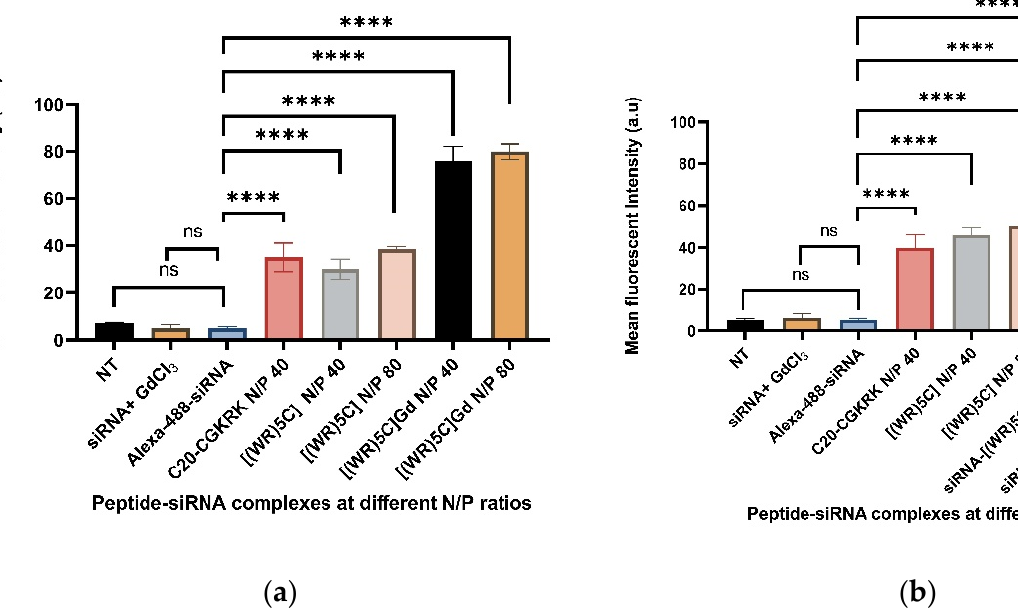
Figure 6. ( a ) Cellular uptake of Alexa-488 siRNA in the presence of [(WR) 5 C] and [(WR) 5 C]-GdNPs at different ratios after 6 h incubation in ( a ) CCRF-CEM cells (ns = non-significant, if p < 0.0001 then ****) and ( b ) in MDA-MB-231 cells (ns = nonsignificant, if p < 0.0001 then ****).